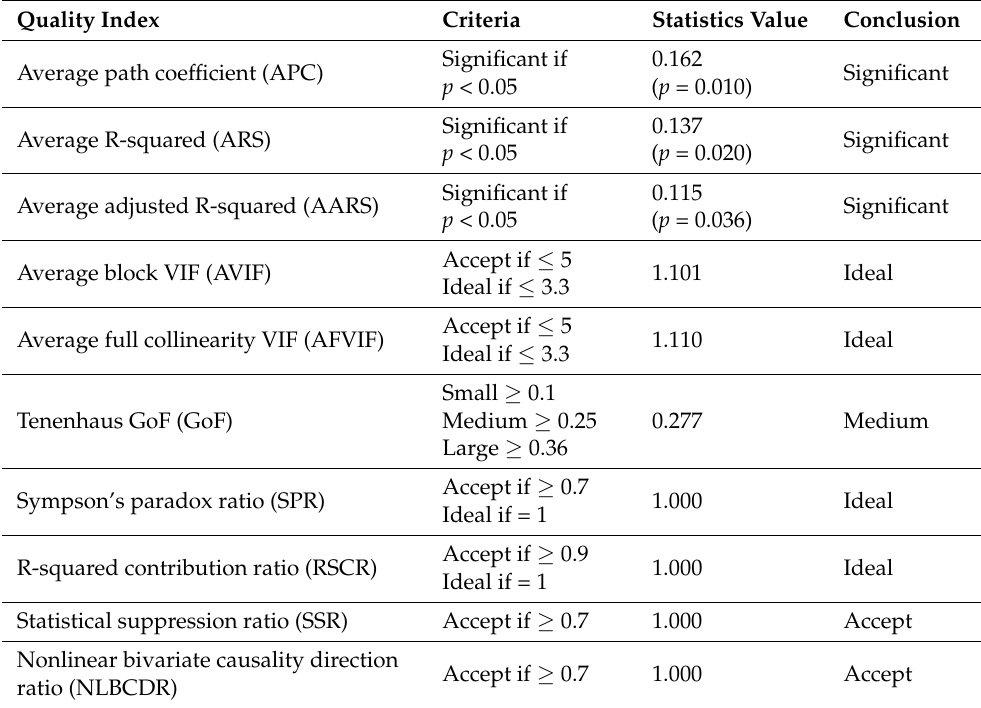
Table 6. Research Model Quality